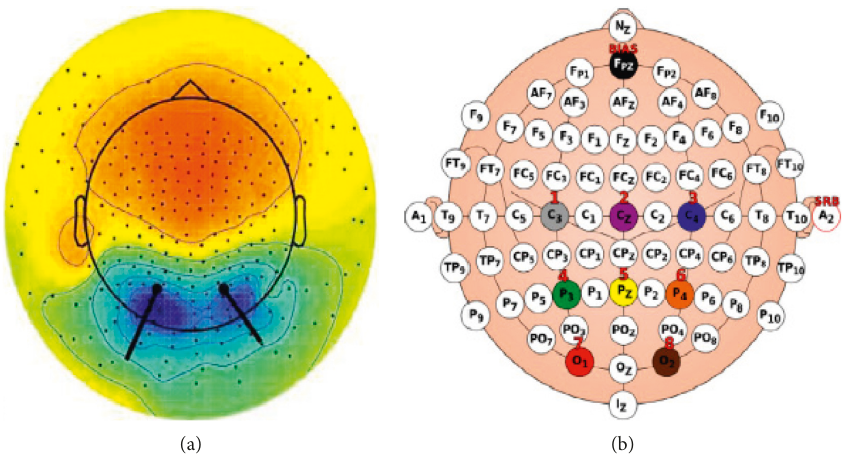
Figure 1: Sample of electrode mapping using an EEG cap [6].